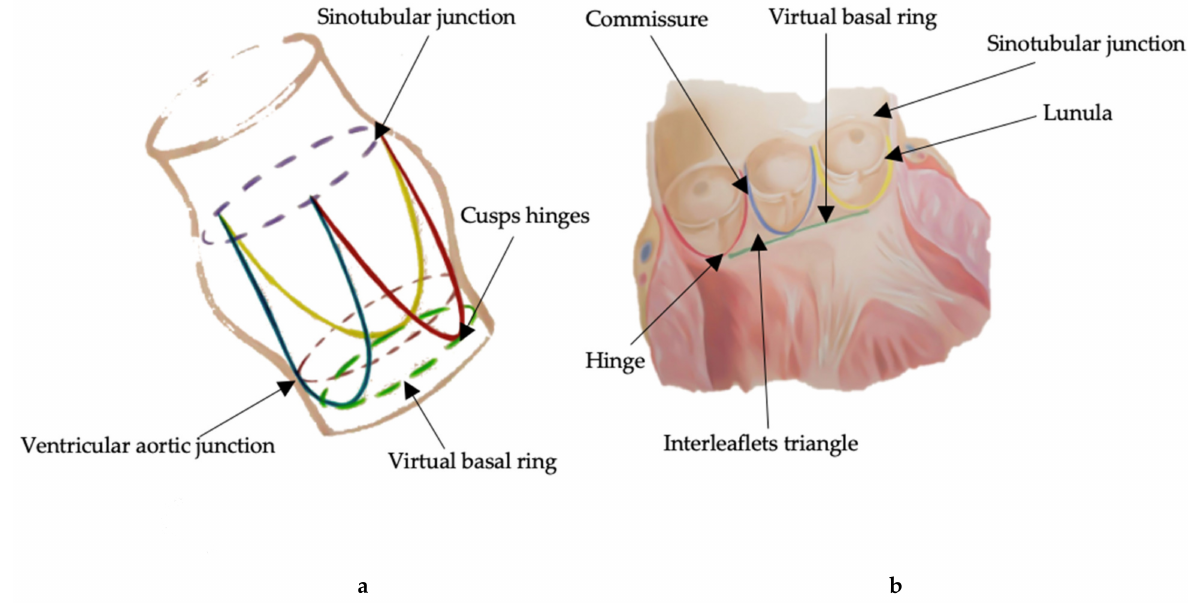
Figure 1. ( a ) Schematic representation of aortic valve anatomy. The dotted blue line indicates the sinotubular junction, the dotted green one depicts the virtual basal ring, and the dotted red one shows the ventricular aortic junction. ( b ) Graphic representation of an opened aortic root with its anatomical